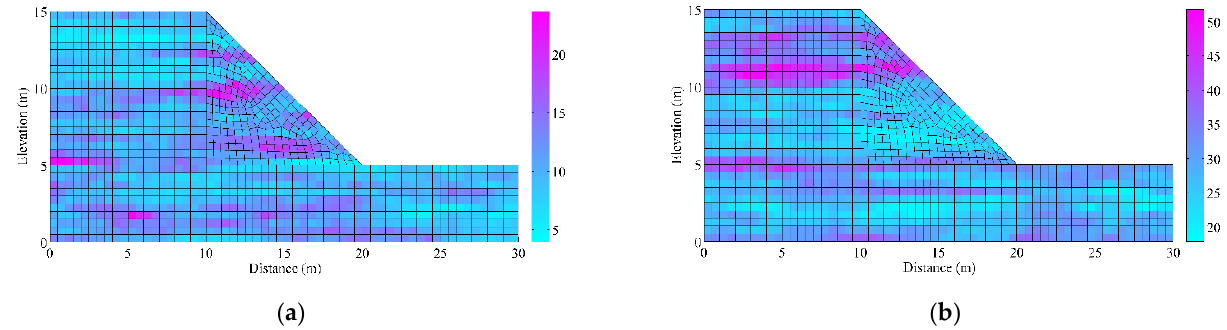
Figure 5. A typical realization of Plackett copula-based transversely anisotropic CCRF. ( a ) Random field of c . ( b ) Random field of ϕ.